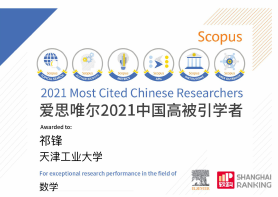
Figure 5. Certificate of the 2021 Most Cited Chinese Researchers.